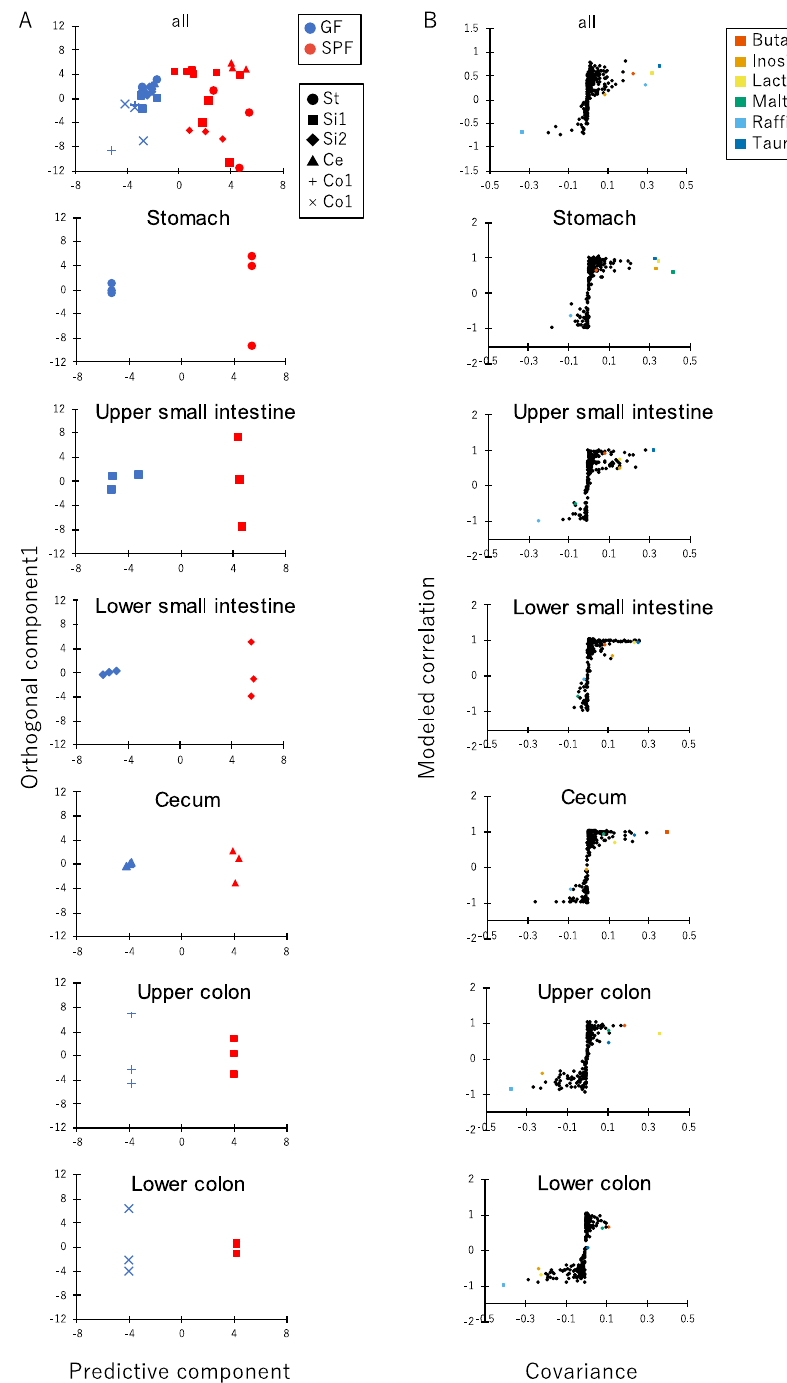
Figure 3. Orthogonal projections to latent structures-discriminant analysis (OPLS-DA) of the luminal metabolome profiles of the gastrointestinal tract of SPF and GF mice. ( A ) The result of OPLS-DA. The red and blue colors indicate the SPF and GF mice, respectively ( n = 3). ( B ) S-plot for OPLS-DA of each part of the gastrointestinal tract. The criteria for the models were as follows: Cross-validated predicted ability Q2(Y) = 1 and total explained variance R2(X) = 1. The values of cross-validated predicted ability and total explained covariance for the stomach, upper small intestine, lower small intestine, cecum, upper colon, and lower colon in the constructed models were: Q2(Y) = 0.96 and R2(X) = 0.93, Q2(Y) = 0.99 and R2(X) = 0.98, Q2(Y) = 0.99 and R2(X) = 0.89, Q2(Y) = 1 and R2(X) = 1, Q2(Y) = 1 and R2(X) = 1,